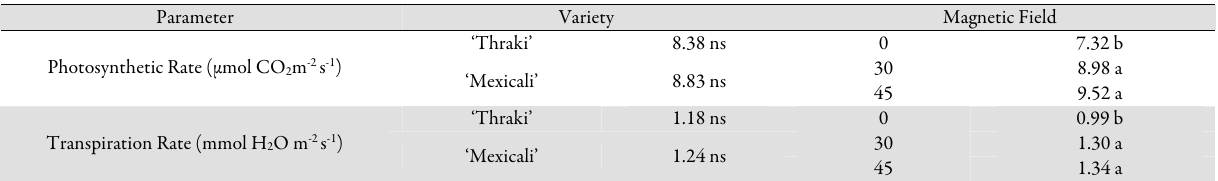
Table 2. Pulsed electromagnetic field and variety effect on physiological measurements of two durum wheat varieties. Seeds have been treated for 0 (control), 30 and 45 minutes with magnetic